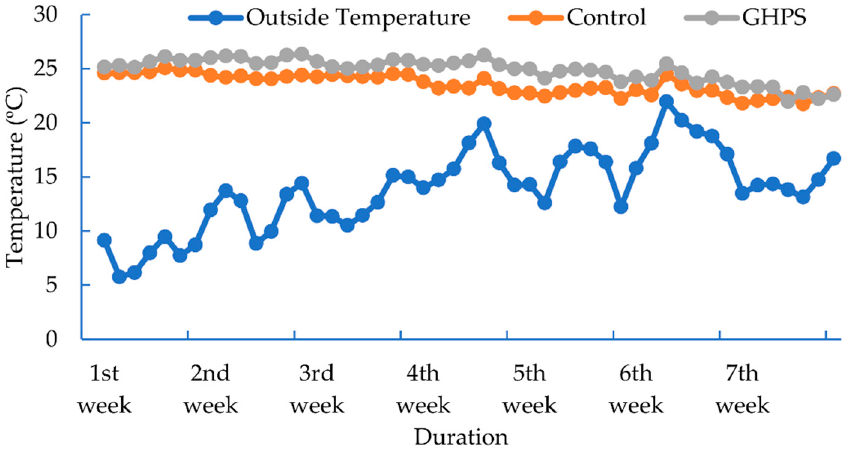
Figure 4. The temperature of the outside, control, and combined geothermal and solar heating system (GHPS).